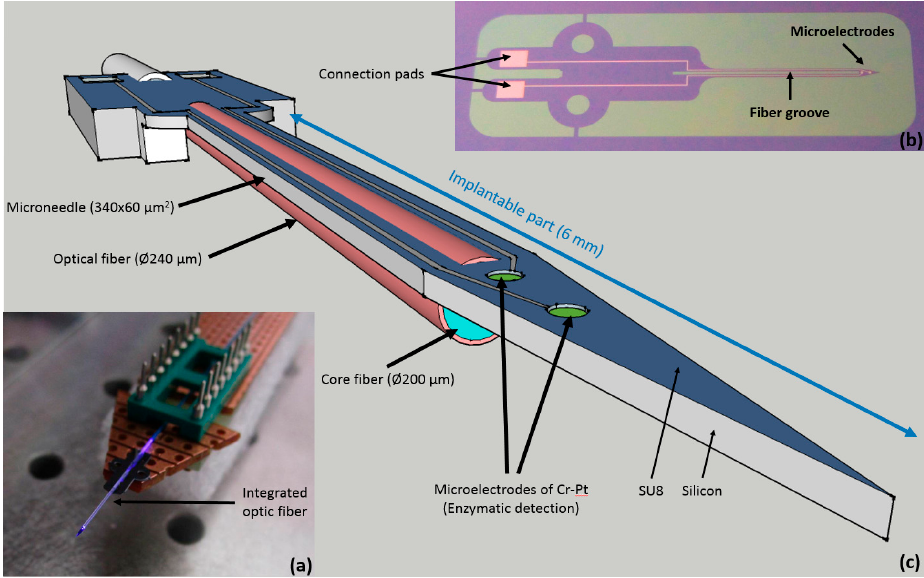
Figure 1. The probe design. ( a ) Multiphysics probe with light emission, back side view; ( b ) Top view of the micromachined probe with electrical contacts; ( c ) Schematic of the probe